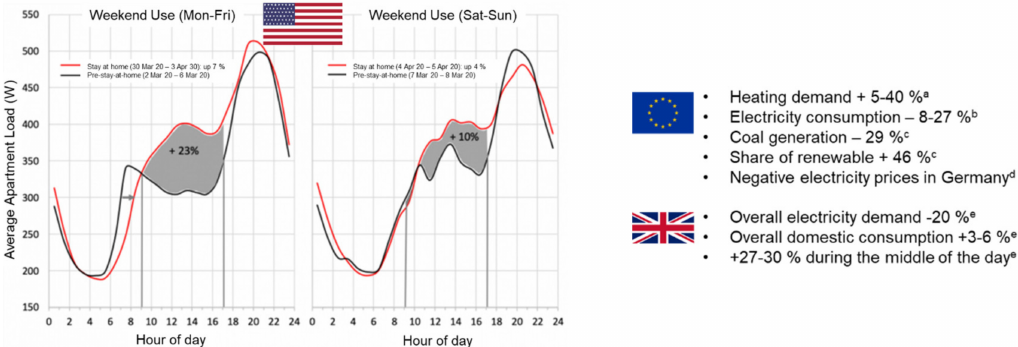
Figure 3. The structural changes and impacts of energy demand during movement restriction of